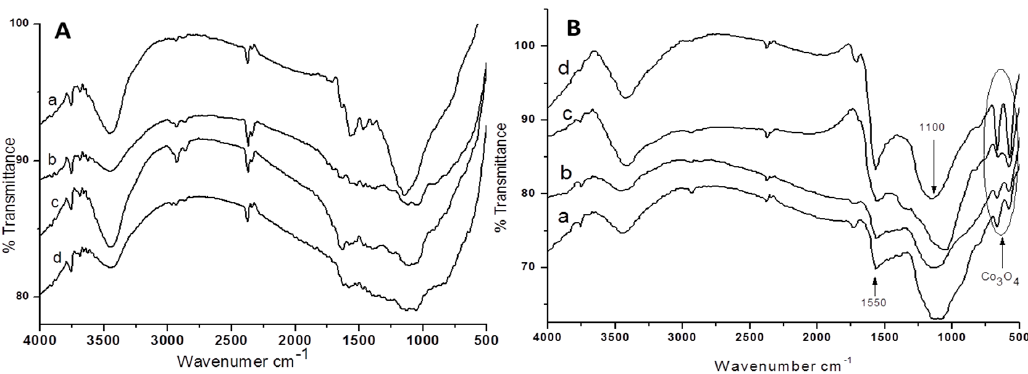
Figure 2. IR spectra of ( A ) supports: ( a ) G60, ( b ) RX3, ( c ) RB3, and ( d ) CNR; ( B ) catalysts: ( a ) Co 3 O 4 /RB3, ( b ) Co 3 O 4 /RX3, ( c ) Co 3 O 4 /CNR, ( d ) Co 3 O 4 /G60.